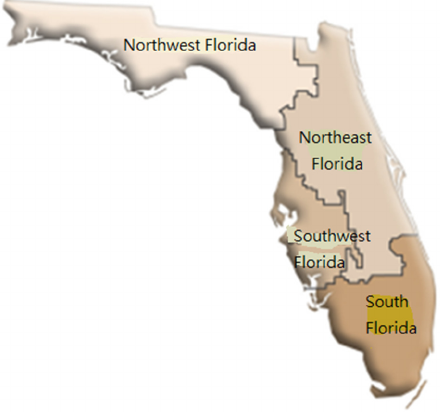
Figure 2. Map of Florida depicting the four regions of the State (revised from [34]).